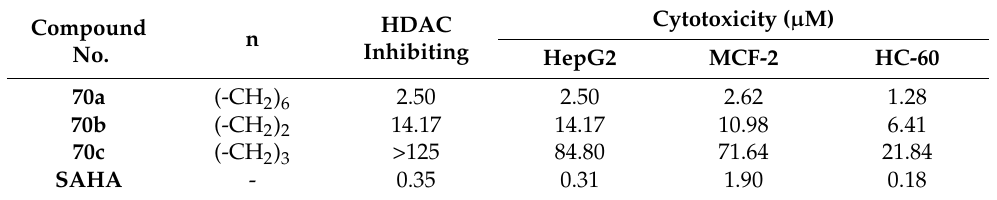
Figure 68. Structure of hydroxamate ‐β‐ carboline based hybrid derivatives ( 71 ). Table 56. In vitro cytotoxic activities of hydroxamate ‐β‐ carboline based hybrid compounds 71 ( a – d ). Compounds No.